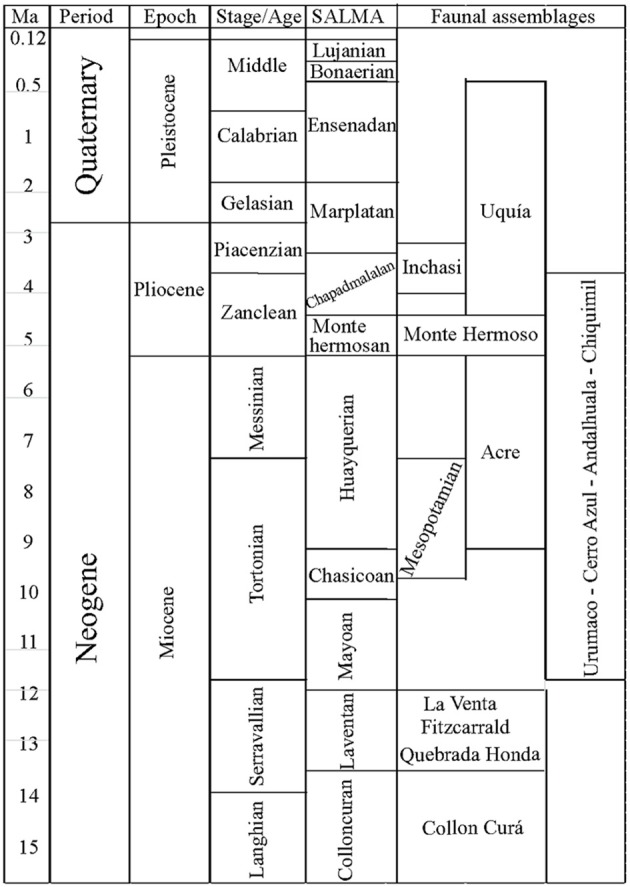
Chronostratigraphy, South American Land Mammal Ages (SALMAs) and temporal distribution of the faunal assemblages discussed in the text. Colloncuran:15.7–14 Ma (Madden et al., 1997) Laventan: 13.5–11.8 Ma. (Madden et al., 1997); Mayoan: 11.8–10 Ma. (Flynn and Swisher, 1995); Chasicoan: 10– ~8.5 (Flynn and Swisher, 1995); Huayquerian = ~8.5–5.28 Ma. Lower age following (Cione and Tonni, 2001; Reguero and Candela, 2011) and upper age following (Tomassini et al., 2013); Montehermosan = 5.28 –4.5/5.0 Ma. (Tomassini et al., 2013); Chapadmalalan = 4.5/5.0–3.3 (Tomassini et al., 2013); Marplatan = 3.3 – ~2.0 Ma. Lower age following (Tomassini et al., 2013) and upper age following (Cione and Tonni, 1999; Cione et al., 2007); Ensenadan = ~2.0–<0.78(0.5?) Ma. (Cione and Tonni, 1999; Cione et al., 2007); Bonaerian = <0.78(0.5?)–0.13 Ma. (Cione and Tonni, 1999); Lujanian = 0.13–0.08 Ma (Cione and Tonni, 1999).